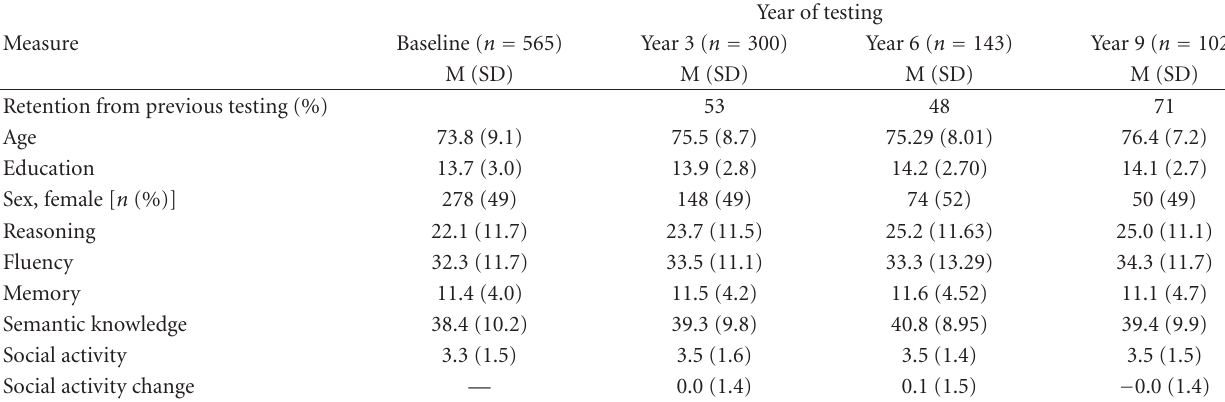
Table 2: LBLS participant